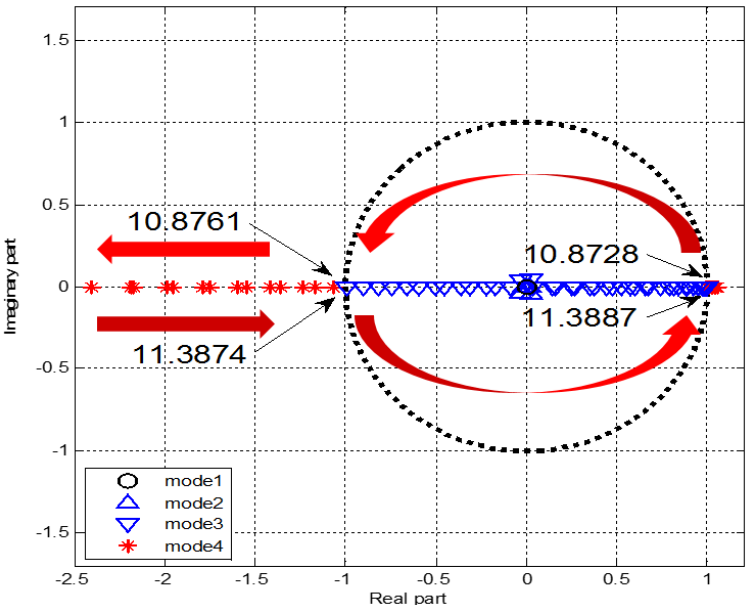
Figure 8. Trajectory of Floquet multiplier for three-bus power